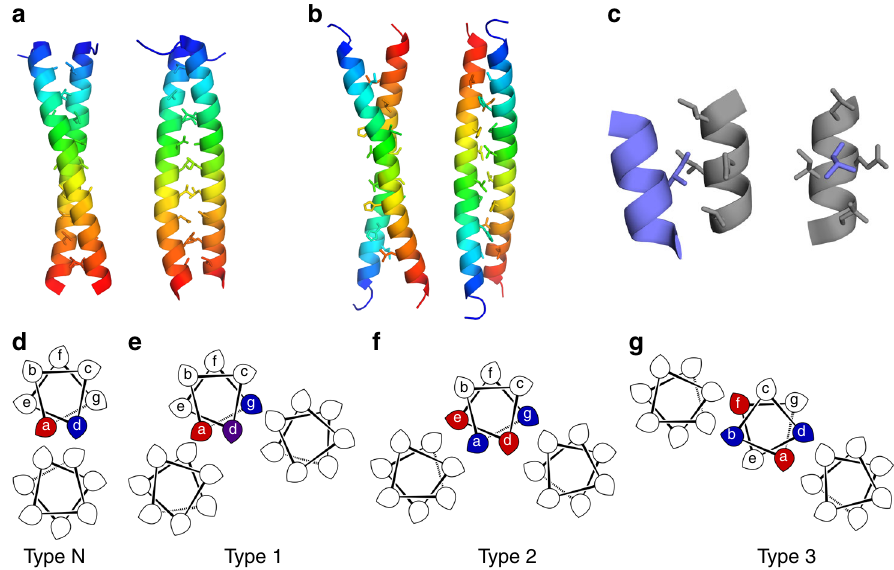
Fig. 1 Coiled-coil structure, symmetry and sequence. a , b Parallel (C 2 symmetric; PDB entry 4DZM) and antiparallel (D 1 symmetric; 1HF9) CC dimers. c Knobs-into-holes (KIH) interaction with an isoleucine knob packing into a diamond-shaped hole (grey). d – g Helical wheels for classical Type-N ( d ), and for Type-1 ( e ), Type-2 ( f ) and Type-3 interfaces ( g ). All are viewed along the α -helices from the N to C termini, labels are for the canonical a – g nomenclature, and the teardrop shapes indicate the direction of C α – C β bonds. Coloured residues highlight knobs in KIH interactions with parallel (red), perpendicular (blue) and X-layer (purple) KIH types. Unlabelled helices are for